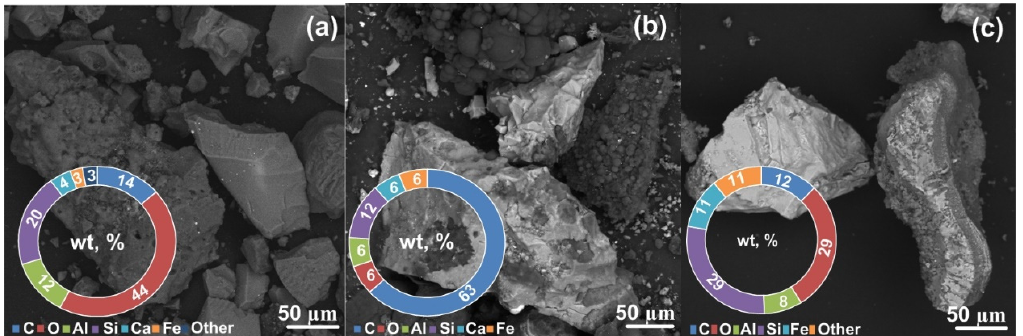
Figure 4. SEM results for the initial slag ( a ), the synthesized product ( b ), and the carbon-free product ( c ).